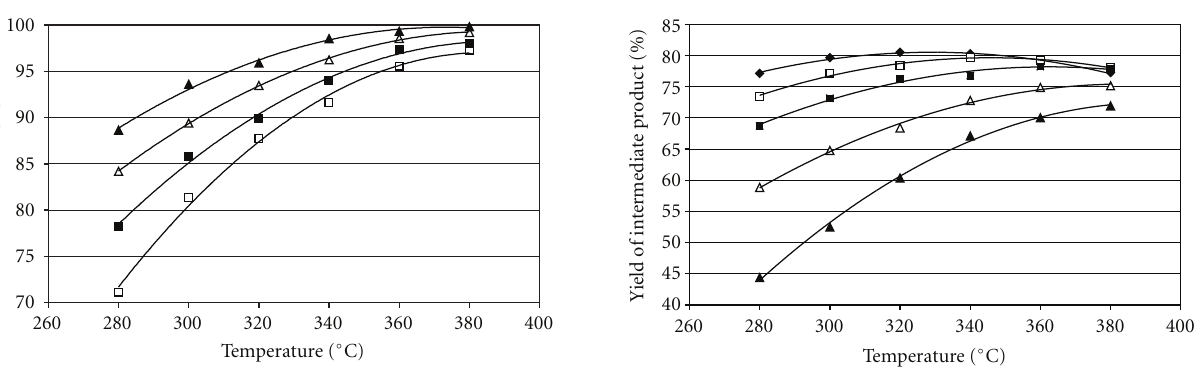
-20 bar, -40 bar, Δ -60 bar and (cid:0) (cid:2)